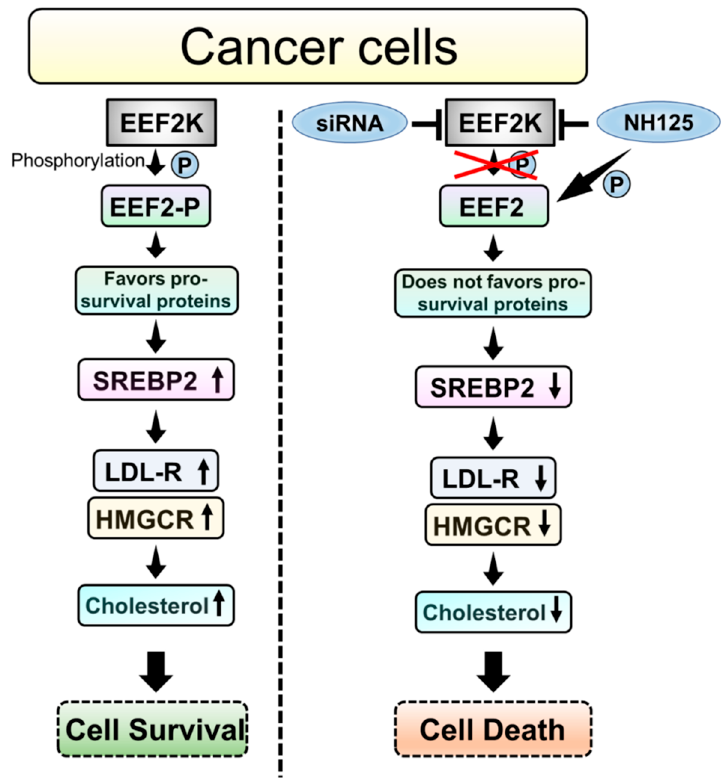
Figure 7. Schematics of mechanisms by which targeting EEF2K with siRNA or NH125 inhibit melanoma cell survival. Active EEF2K mediates protein translation through EEF2 and increases the levels of SREBP2, LDLR and HMGCR to increase cellular cholesterol and promote cell growth in cancer cells. Targeting EEF2K by siRNA and NH125 decreases the expressions of SREBP2, LDLR and HMGCR, which results in reduced cellular cholesterol and increased cell